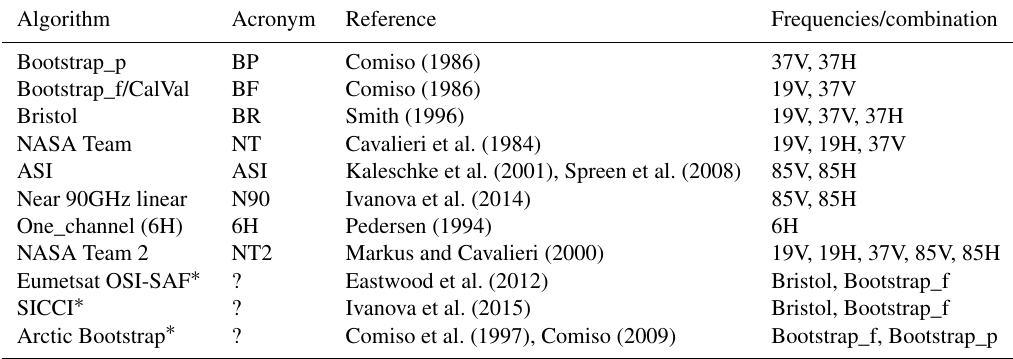
Table 4. The sea-ice concentration algorithms. ∗ Analysis not shown in this study.